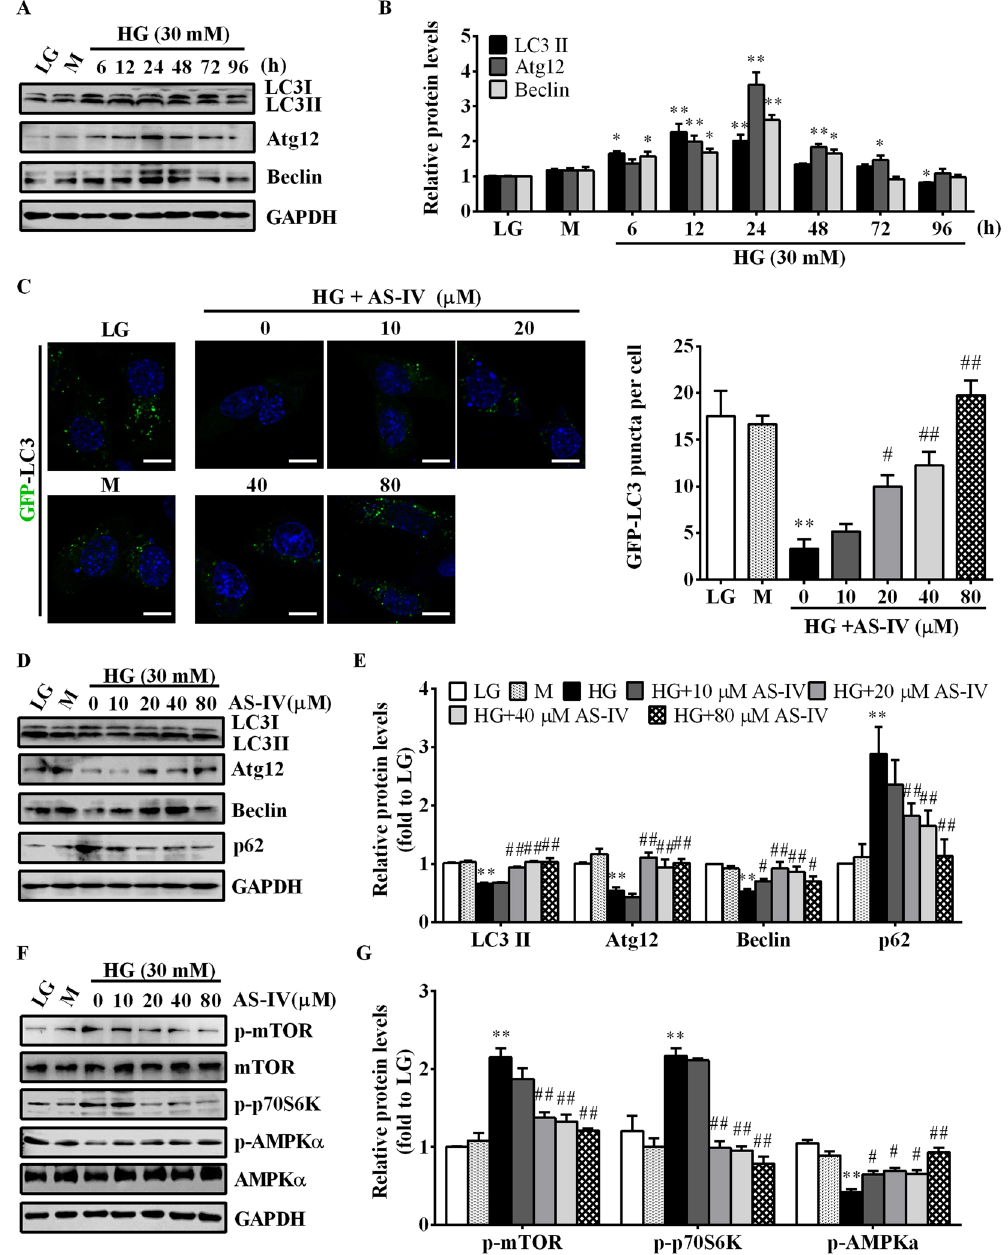
Figure 8. AS-IV improved HG-compromised autophagy activity in podocytes. ( A , B ) Podocytes were treated with 30 mM HG for 6, 12, 24, 48, 72 and 96 h. LG and M were used as controls. Western blot analyses ( A ) and densitometric quantification ( B ) of autophagy-related protein expression at various time points. Data are expressed as mean ± SEM. n = 3. * P < 0.05, ** P < 0.01 compared to LG group. ( C – G ) Podocytes were pretreated with or without AS-IV at the indicated concentrations for 2 h followed by GFP-LC3 expression plasmid transfection and HG exposure for 72 h. ( C ) Representative images showing the autophagic flux after AS-IV treatment and quantification of GFP-LC3 puncta per cell in each group. The appearance of dot-like GFP-LC3 puncta indicated autophagosome formation. Scale bars, 10 μ m. ( D , E ) Western blot analyses ( D ) and densitometric quantification ( E ) of LC3A/B, Atg12, Beclin and p62 expression in each group. ( F , G ) Western blot analyses ( F ) and densitometric quantification ( G ) of p-mTOR, p-p70S6K and p-AMPK α expression in each group. The original blots for panel A, D and F were presented in Supplementary Figure S9. Data are expressed as mean ± SEM. n = 3. ** P < 0.01 compared to LG group. # P < 0.05, ## P < 0.01 compared to HG group. One- way ANOVA and Newman-Keuls multiple comparisons test ( B , E , G ). LG, low glucose; M, mannitol; HG, high